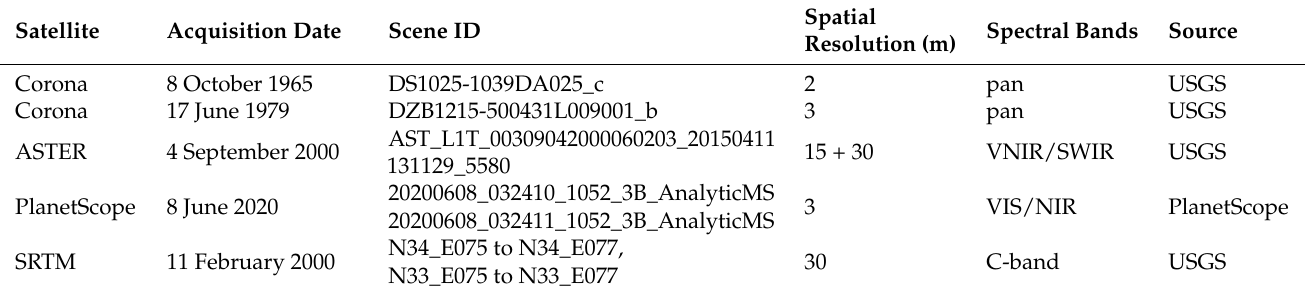
Table 1. Details of satellite datasets used in the study.